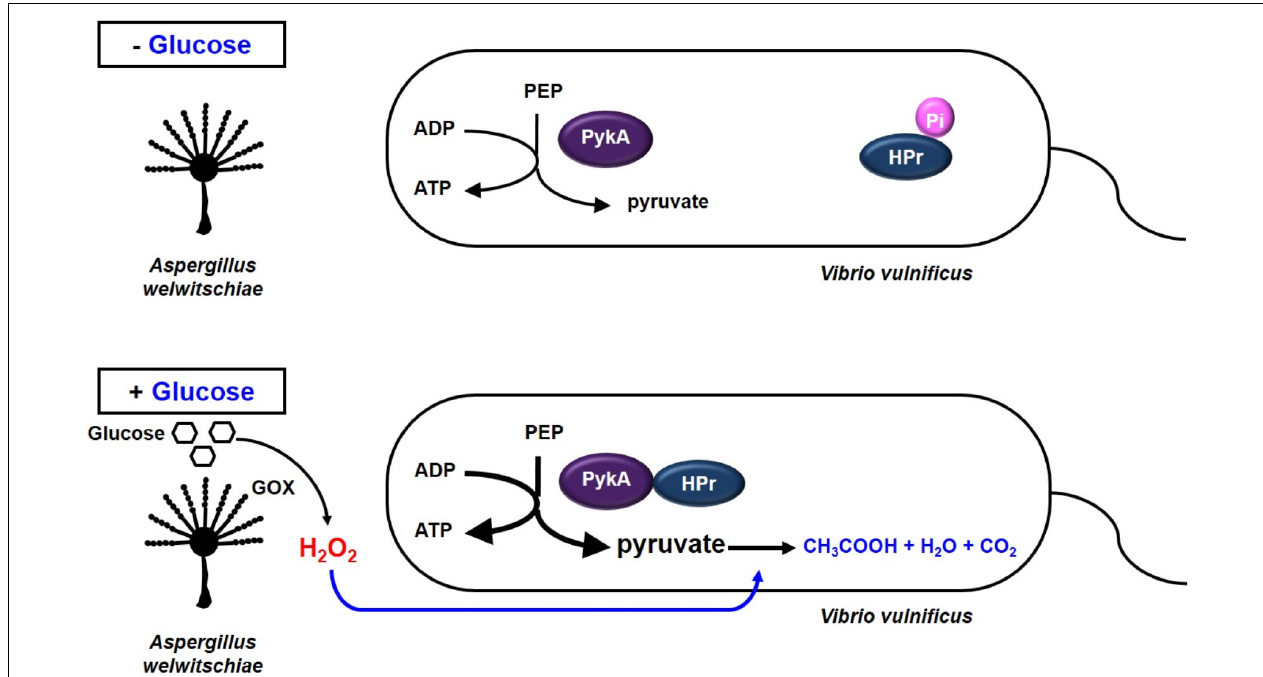
FIGURE 6 | Model showing how V. vulnificus cells cope with H 2 O 2 stress in the presence of glucose. Some fungi are known to inhibit bacterial growth in the presence of glucose by generating H 2 O 2 through the reaction catalyzed by glucose oxidase. Meanwhile, HPr of the PEP-dependent carbohydrate-transporting phosphotransferase system is dephosphorylated in the presence of glucose, and dephosphorylated HPr stimulates pyruvate kinase A in V. vulnificus . The increased pyruvate production then enables this bacterium to cope with H 2 O 2 stress imposed by their fungal neighbors or other environmental factors.